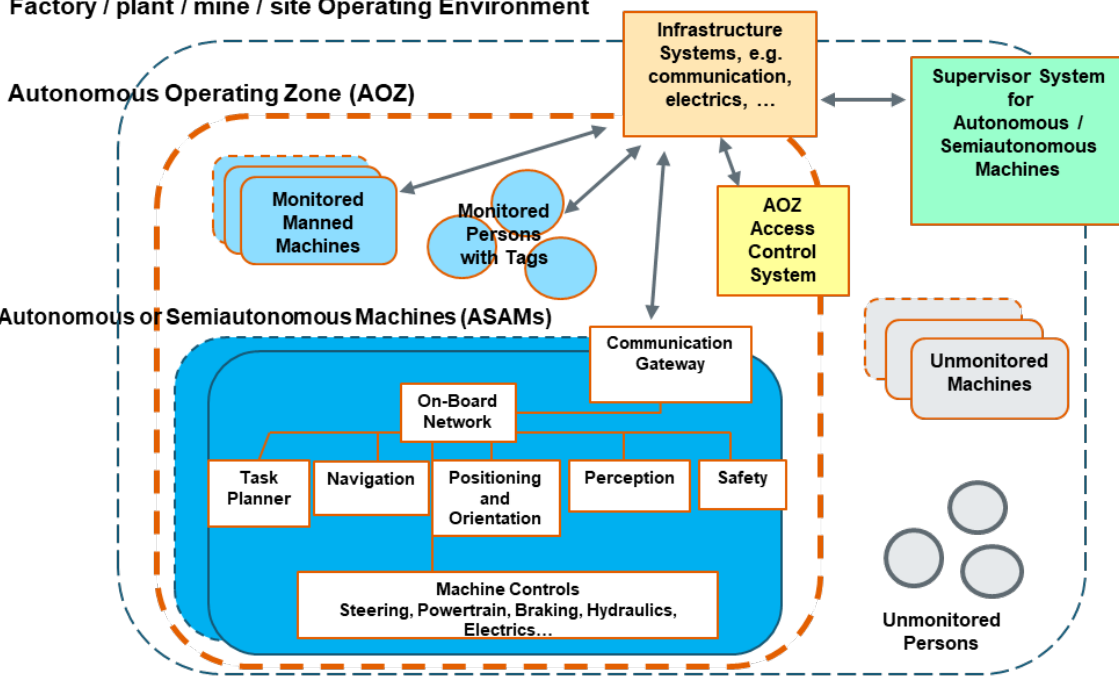
Figure 2: An illustration of the difference between the monitored and un-monitored persons and machinery in relation with the AOZ accord- ing to the ASAMS model shown in ISO 17757